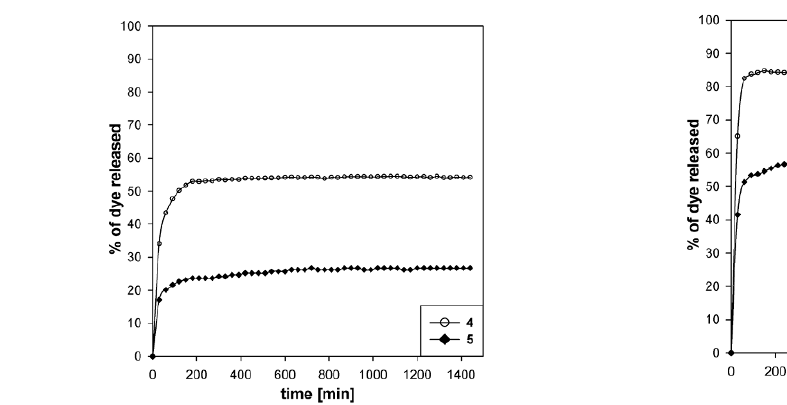
Figure 8. Release of 1 from modified MCM-41 silica at pH= 6.8.